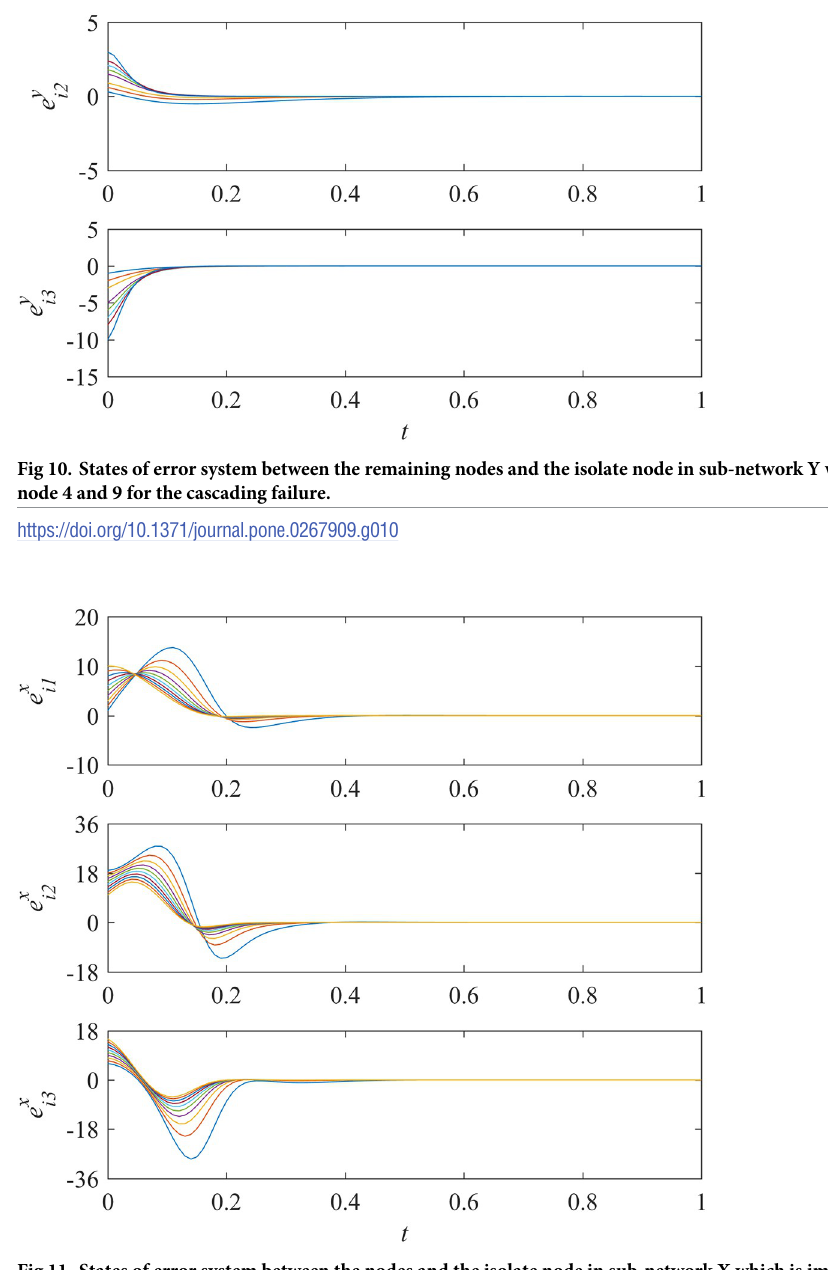
PLOS ONE | https://doi.org/10.1371/journal.pone.0267909 May 5,